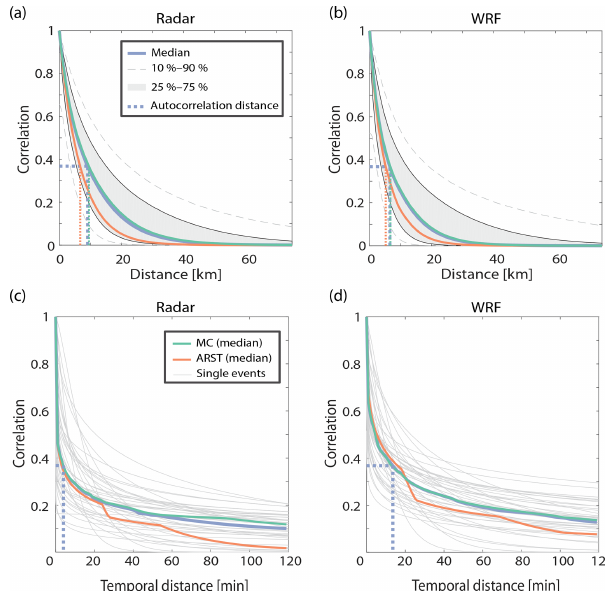
Figure 12. A 1-D exponential fitting of the rain field spatial (a, b) and temporal (c, d) autocorrelation values from radar-derived QPE (a, c) and from the WRF model (b, d) . These were computed using 10min snapshots of rain and only for periods where convec- tive rainfall is present. Quantiles in spatial autocorrelation (a, b) represent 11731 snapshots of radar 10min data (10095 of which come from MC-type events) and 14323 WRF rainfall snapshots (12220 of which come from MC-type events). Temporal autocor- relation plots (c, d) are composed of the 41 examined HPEs (grey) as well as their median values for all events (purple), for MC-type only (green) and for ARST-type only